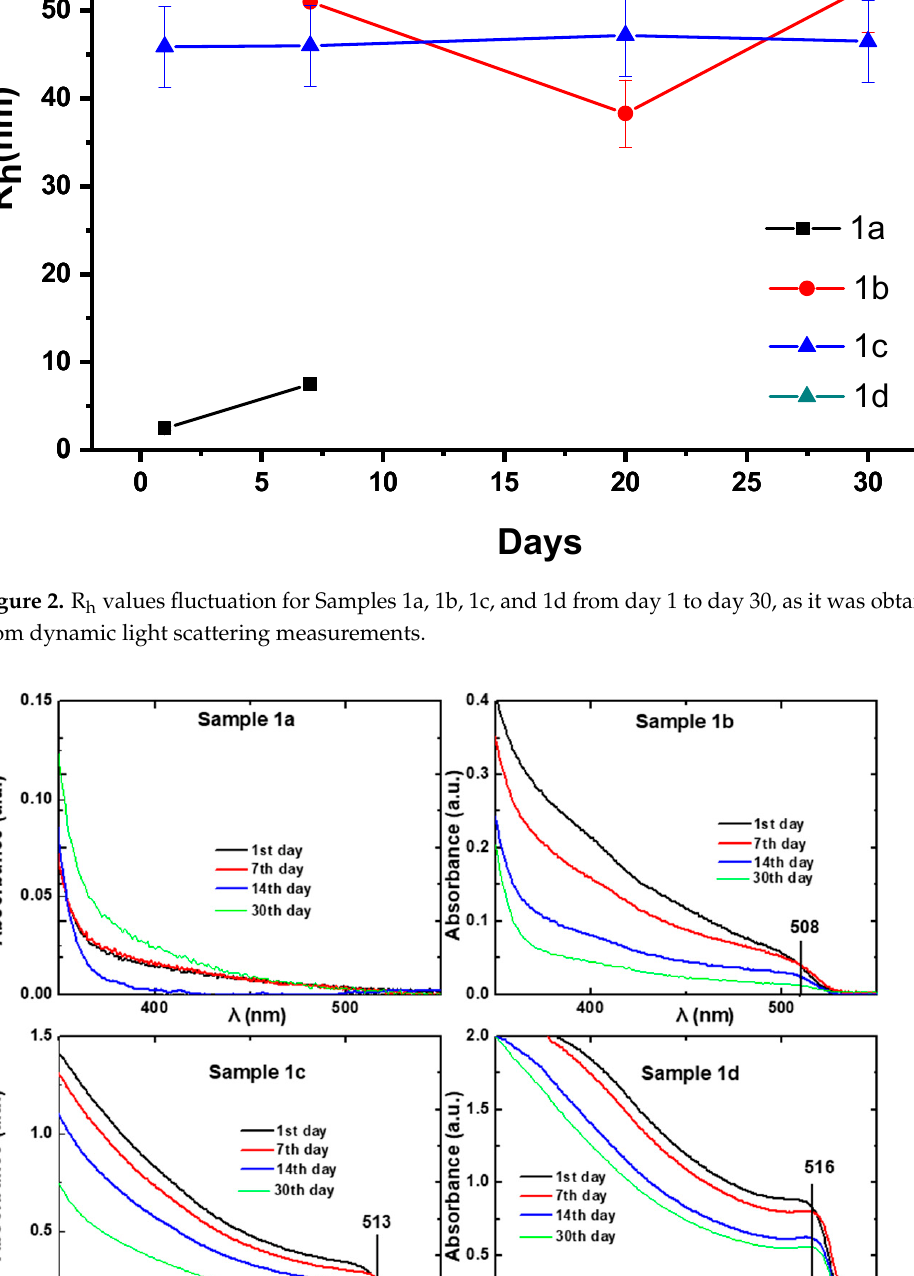
Figure 3. UV-Vis absorption spectra of solutions ( 1a ), ( 1b ), ( 1c ), and ( 1d ) from 1st (black line), 7th (red line) 14th (Blue line), and 30th (green line) day.